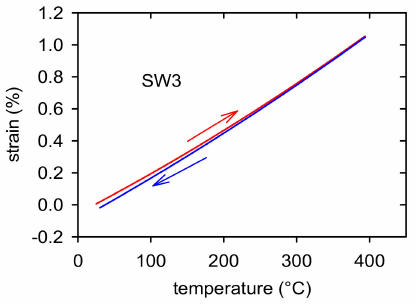
Figure 7. Temperature dependence of thermal expansion measured while heating and cooling for the SW3 sample.